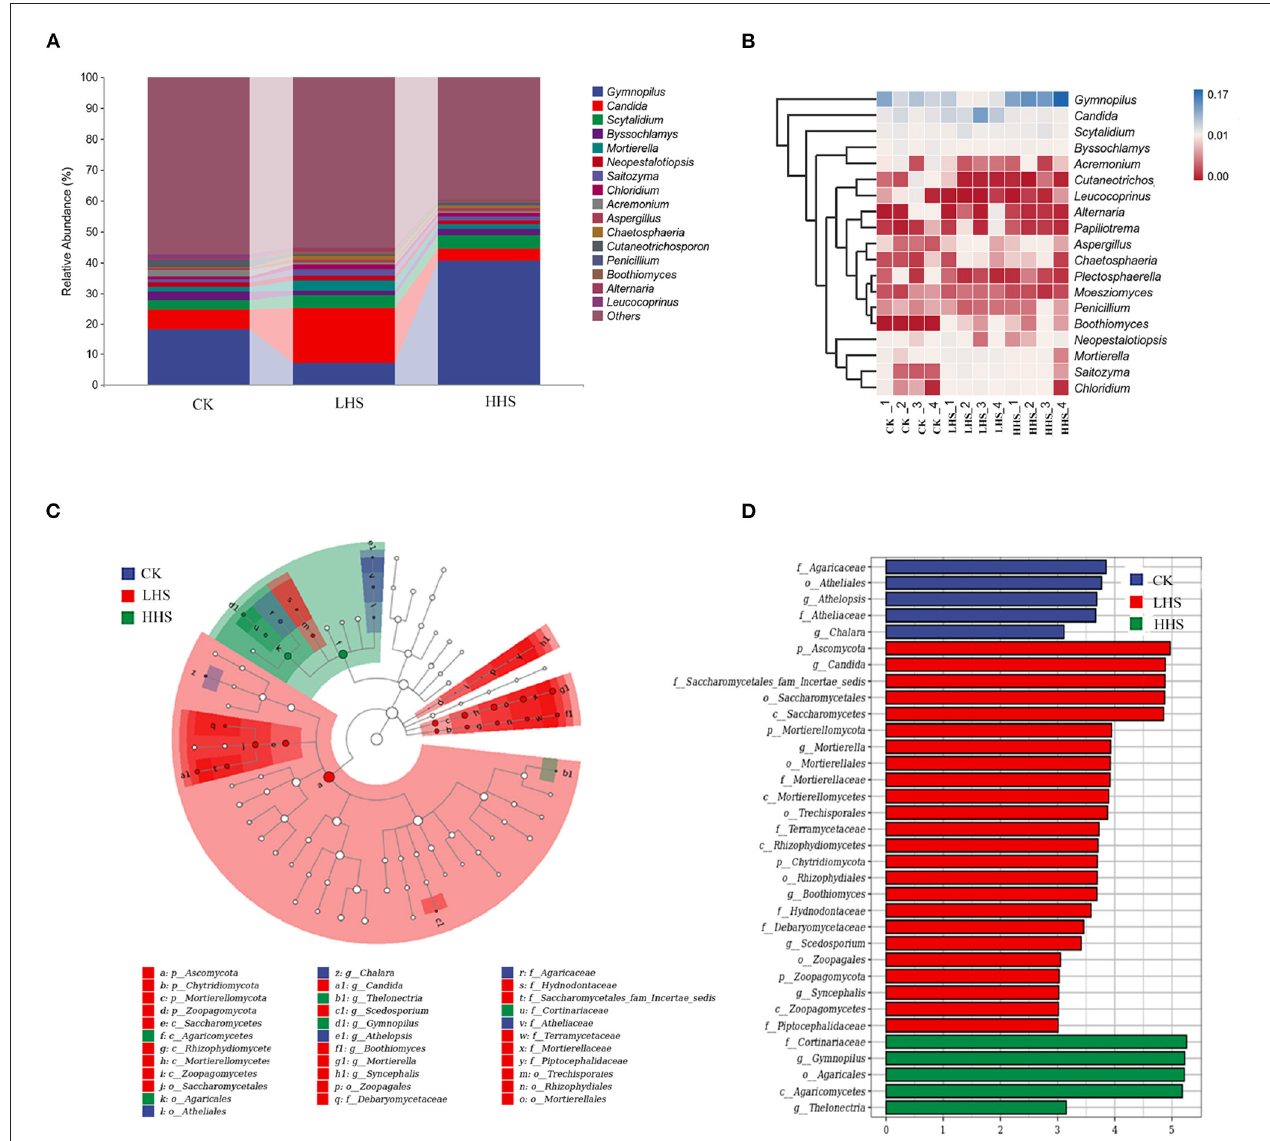
FIGURE 5 | Comparison of fungal communities in CK, LHS and HHS treatments. (A) Fungal taxa at genus level. (B) Heatmap showing changes in microbial community in treatments at genus level. (C) Cladograms indicate the phylogenetic distribution of microbial lineages associated with three treatments. Each circle diameter is proportional to the taxon abundance. The strategy of multiclass analysis is strict (all classes differential). Circles represent phylogenetic levels from Kingdom to genus. (D) LDA bars indicate microbial groups within three treatments with LDA score higher than 3.0. The difference in abundant clades of each treatment are represented by colors as in cladograms, and the LDA scores of these clades indicate the degree of statistically and biologically difference. CK, control (25 /20 ◦ C); LHS, light heat stress (35/30 ◦ C); HHS, high heat stress (40/35 ◦ C); p, phylum; o, order; c, class; f, family; g,